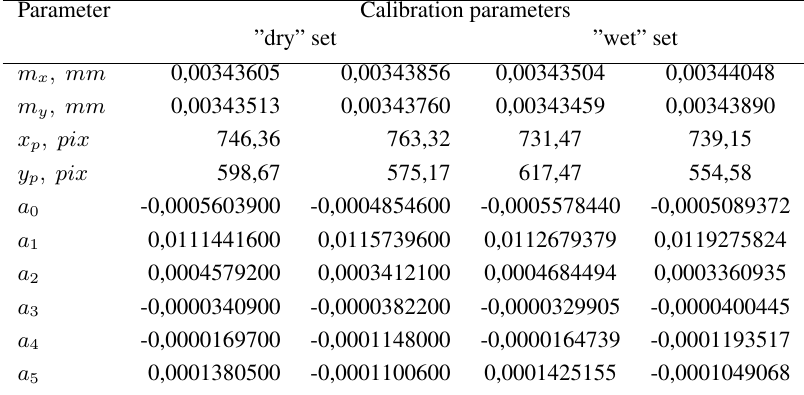
Table 1. Interior orientation parameters